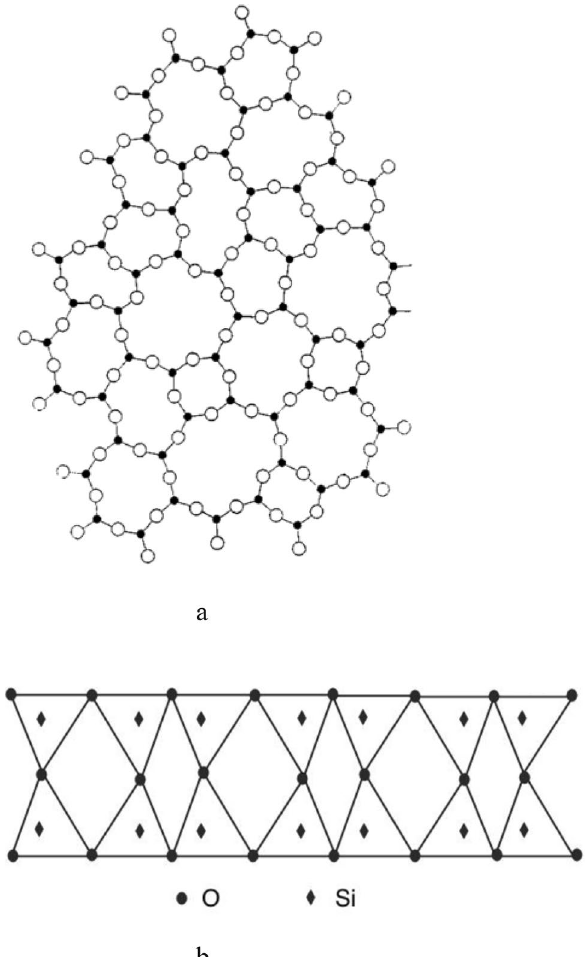
Figure 2. Recently proposed two-layer structure on facets of clusters in silica glass. ( a ) Top view from the direction perpendicular to the layers. ( b ) Side view of the layer structure. Reproduced from Ref. 10